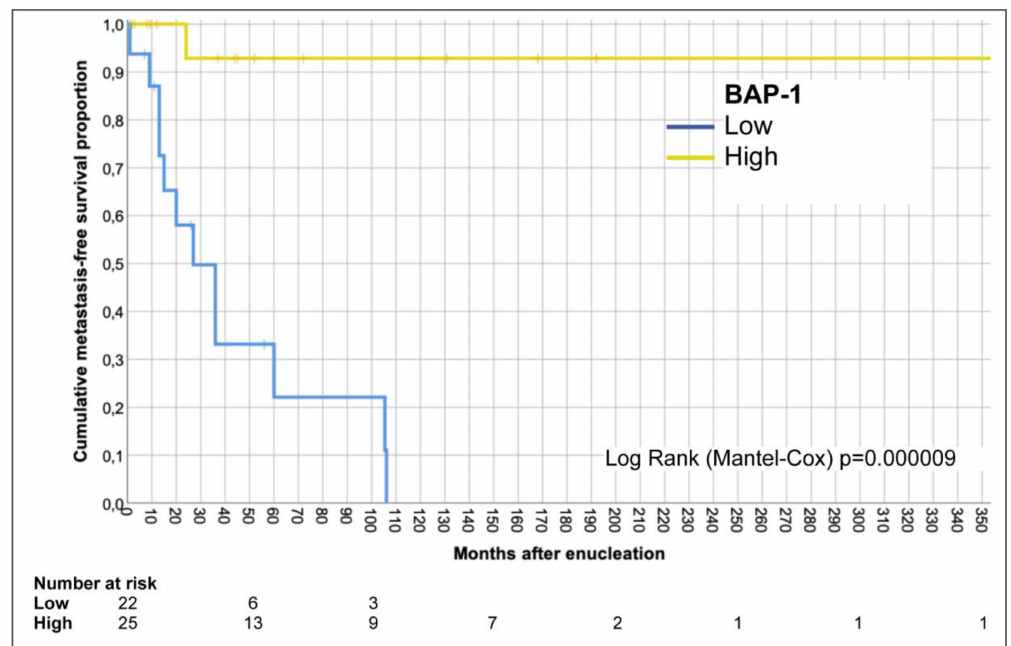
Figure 5. Kaplan-Meier curve. Patients with tumors that had low BAP1-expression, identically classified by both an ophthalmic pathologist and the deep learning network, had significantly shorter cumulative metastasis-free survival than patients with tumors that had high BAP1-expression (Log-Rank p =